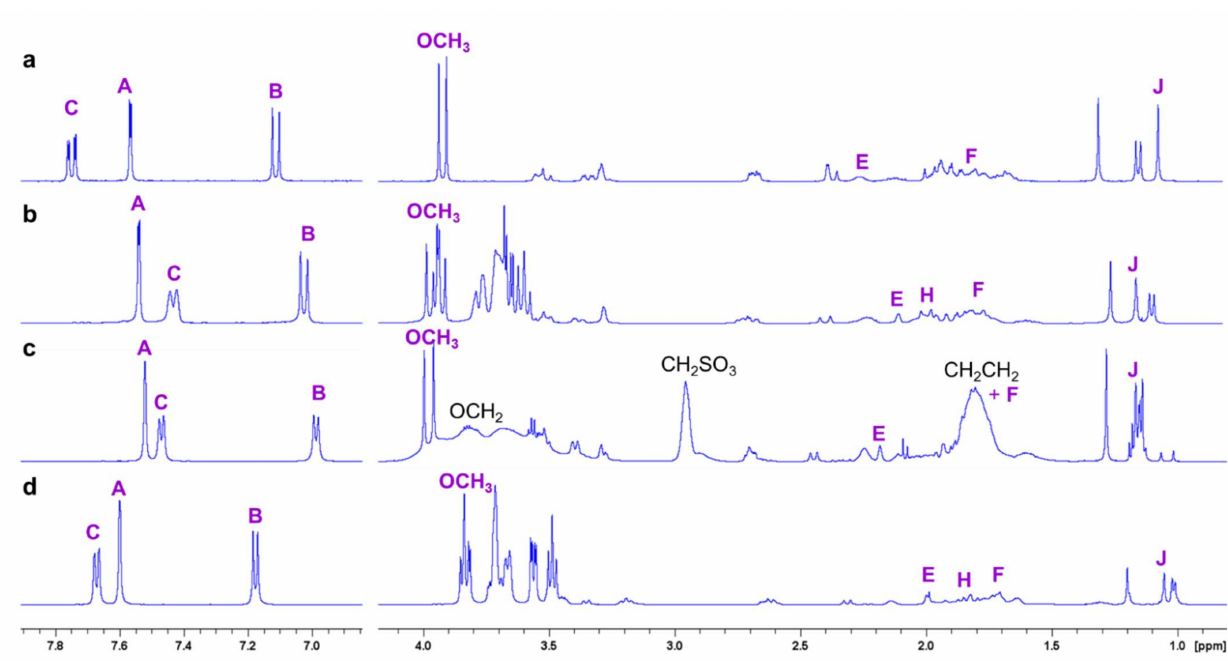
Figure 3. High frequency (left) and low frequency (right) regions of the 1 H-NMR spectra (0.1% DCl in D 2 O, 500 MHz, 298 K) of: ( a ) VTD, ( b ) VTD: β -CD, ( c ) VTD:SBCD, and ( d ) VTD: γ -CD. The VTD protons are identified in violet and the SBCD spacer protons in black (see Figure 1). For the assignment of the other cyclodextrin protons please see Figures 4–6.